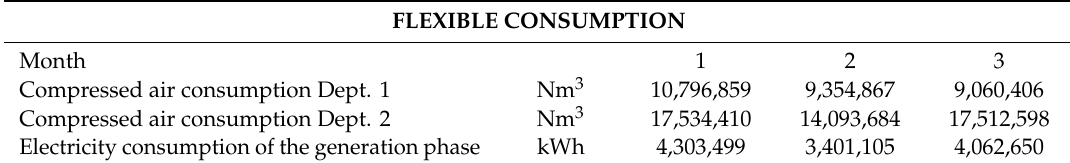
Table 5. Flexible consumption of compressed air and electricity for the considered trimester.